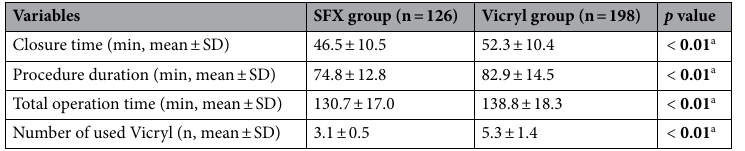
Table 2. Surgical time and the number of threads used according to suture type of THA patients. Significant values are in bold. a By independent t-test. SD, Standard deviation; Closure time, from intraoperative X-ray to skin closure; Procedure duration, from incision to skin closure; Total operation time, from anesthesia to exiting operation room.